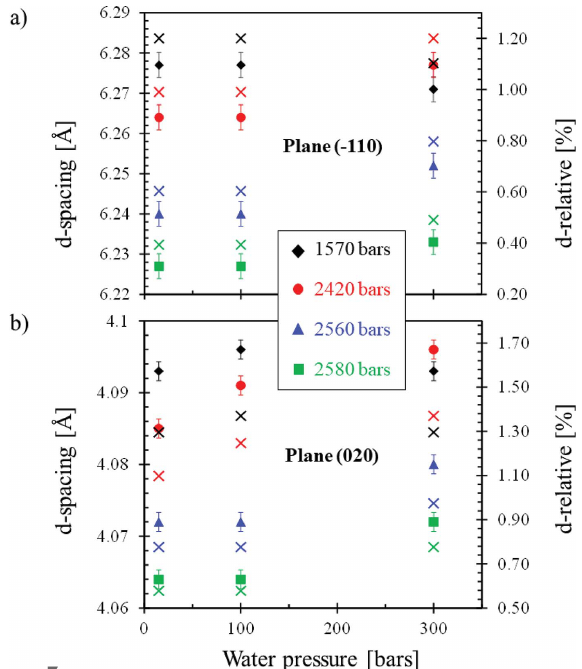
Figure 7 Extracted peak positions from Gaussian fits (filled symbols) and relative variations (cross symbols) with respect to the dry